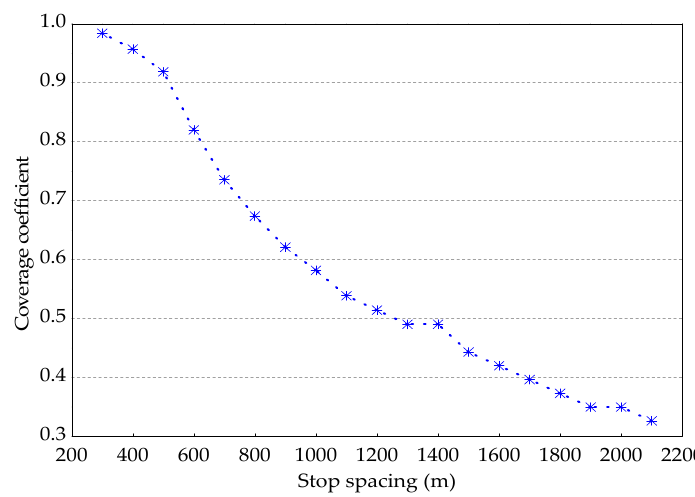
Figure 4. Coverage coefficient of stop spacing.